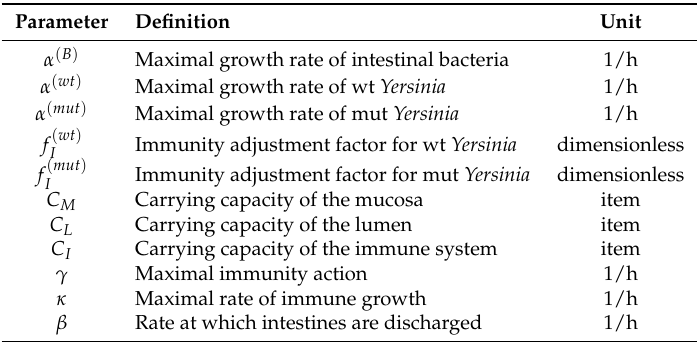
Table 2. Definition of the